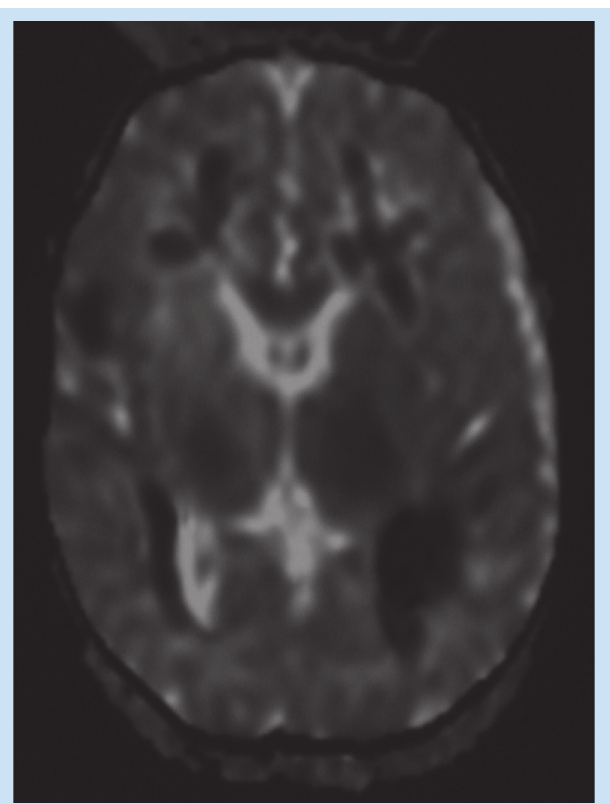
Fig. 4. There is a hypointense area on ADC map in the area of the hae- matoma (‘blackout’). Also note the low density in the periventricular white matter consistent with restricted diffusion.